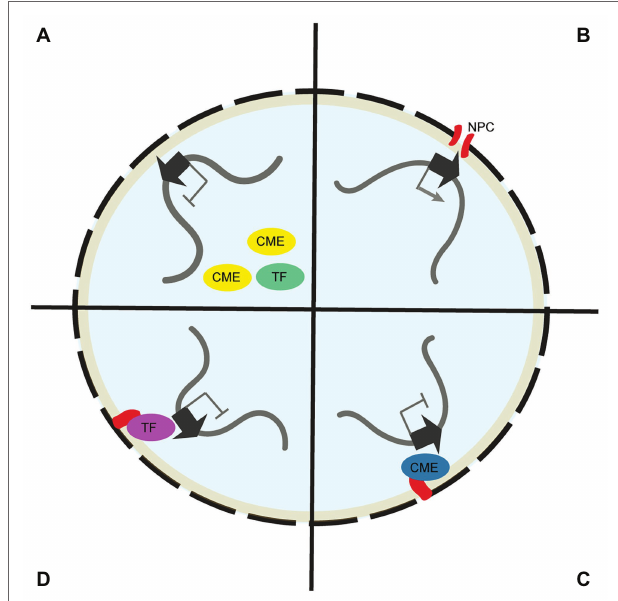
FIGURE 2 | Mechanisms of gene regulation at the nuclear envelope. (A) Chromatin modifying enzymes (CMEs) and transcription factors (TFs) with gene activating function are excluded from the NE. As such, peripheral chromosome regions are devoid of active chromatin marks and activating TFs. (B) Chromosome regions are recruited to the nuclear pore complex (NPC) via nucleoporin interaction. At the NPC, mRNA export is streamlined and loci may interact with NPC associated CMEs. (C) Chromosome regions at the NE are exposed to CMEs with gene silencing activity, such as H3K9 methyltransferases, that are directly linked to the NE. (D) Chromosome regions at the NE are exposed to repressive TFs that are directly linked to the